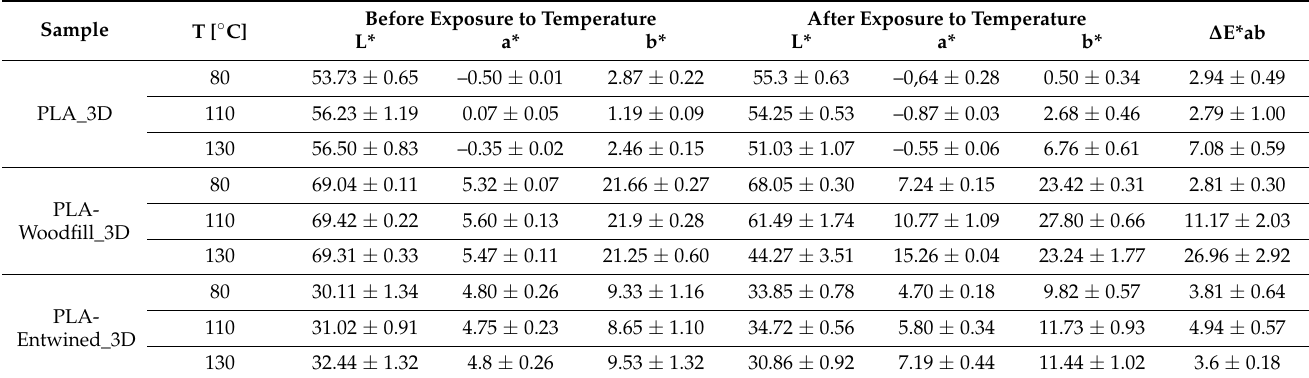
Table 3. L*, a*, b* and ∆ E*ab values of 3D printed samples before and after exposed to high temperatures (80 ◦ C, 110 ◦ C, 130 ◦ C); mean value ±